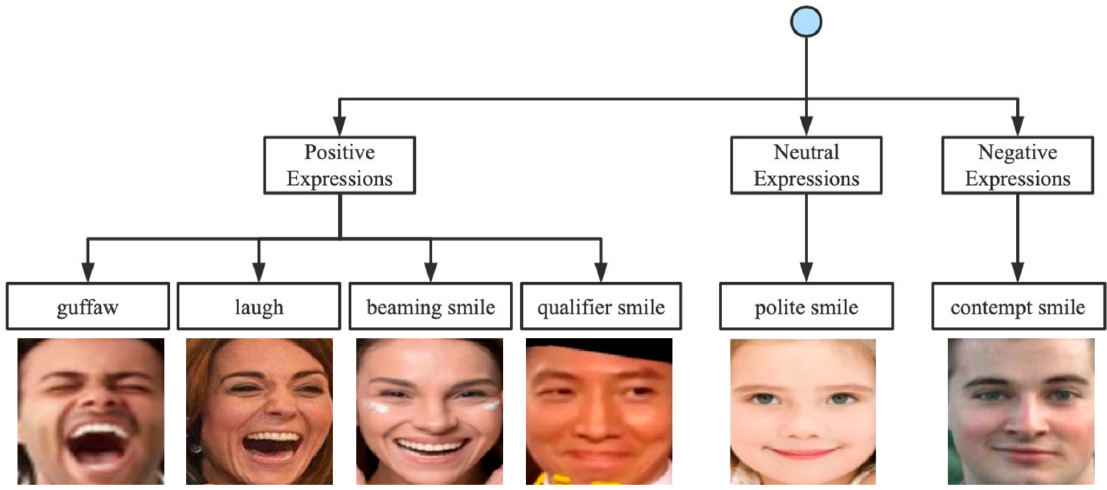
Figure 2. Hierarchical structure adopted in Facial Expression Emotions.